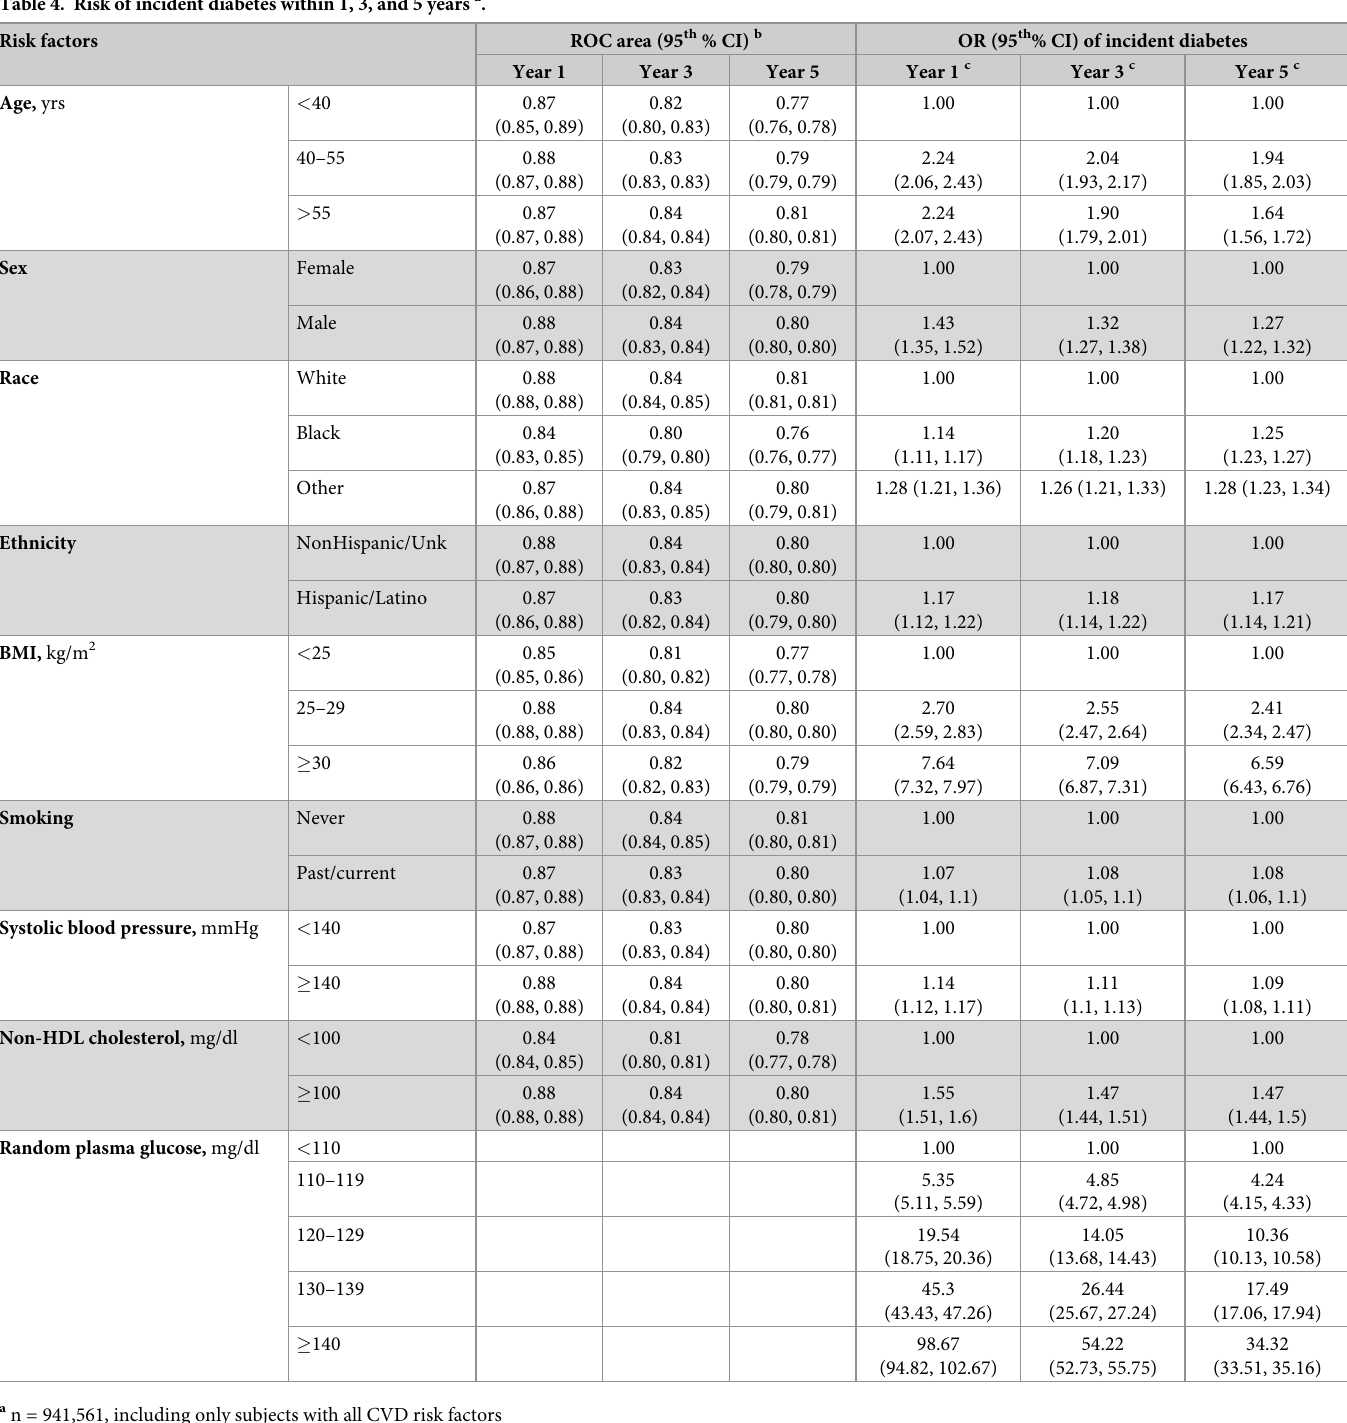
Table 4. Risk of incident diabetes within 1, 3, and 5 years a